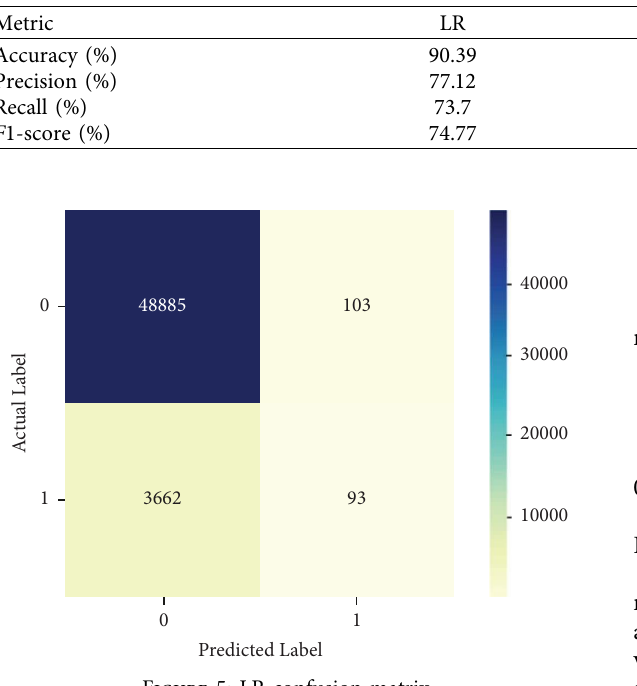
Table 4: Classifcation models without handling imbalanced data.